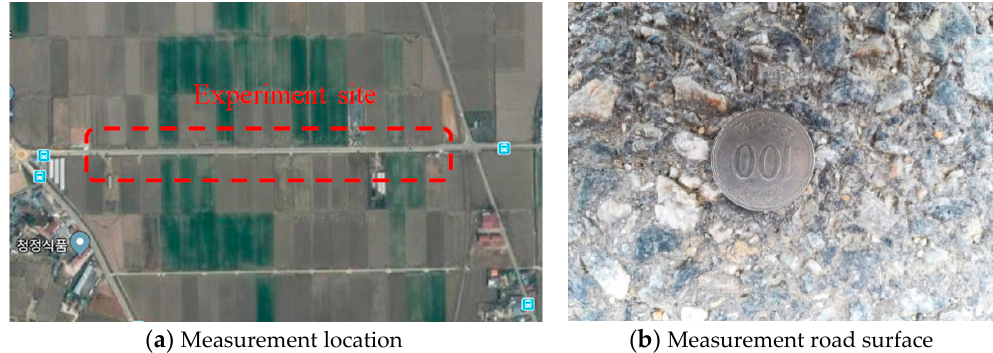
Figure 1. Measurement location and road surface of the controlled pass-by (CPB) and the alternative close proximity (A-CPX) method.